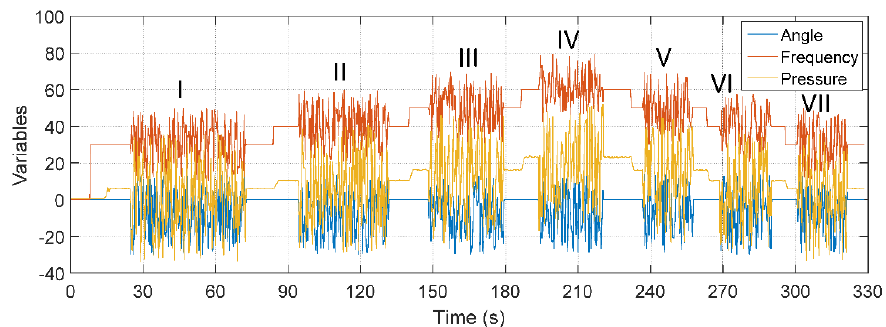
Figure 17. Inputs with noise in PT ‐ 3, CV ‐ 1 and pump.